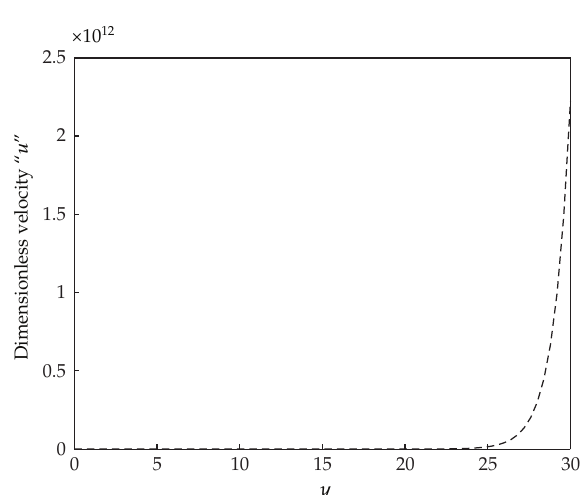
Figure 6: Plot of the forward wave-front type travelling wave solution (cid:3) 4.18 (cid:4) when γ (cid:8) 0 . 5, β (cid:8) 3, c (cid:8) 1, and t (cid:8) π/ 2 are